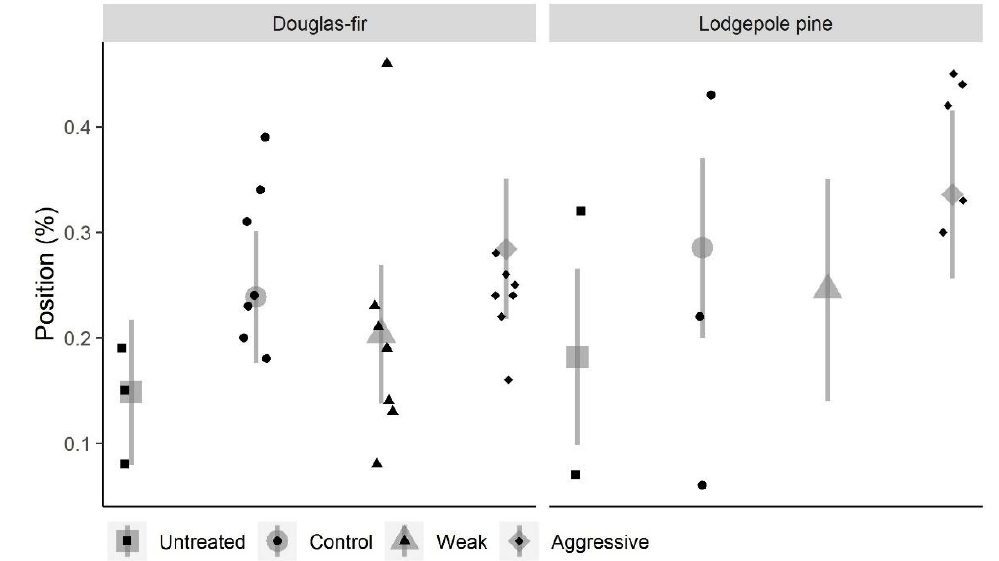
Figure 3. TRD (Douglas-fir) and resin ducts (lodgepole pine) relative position (%) within annual rings in 2019. Observations are shown in black and estimated means are shown in gray with corresponding 95% confidence intervals. No significant differences between species or of treatments within species were found, except between lodgepole pine Aggressive and untreated trees. TRDs that formed in earlier wood (i.e., position (%) > 0.5) were not included in the